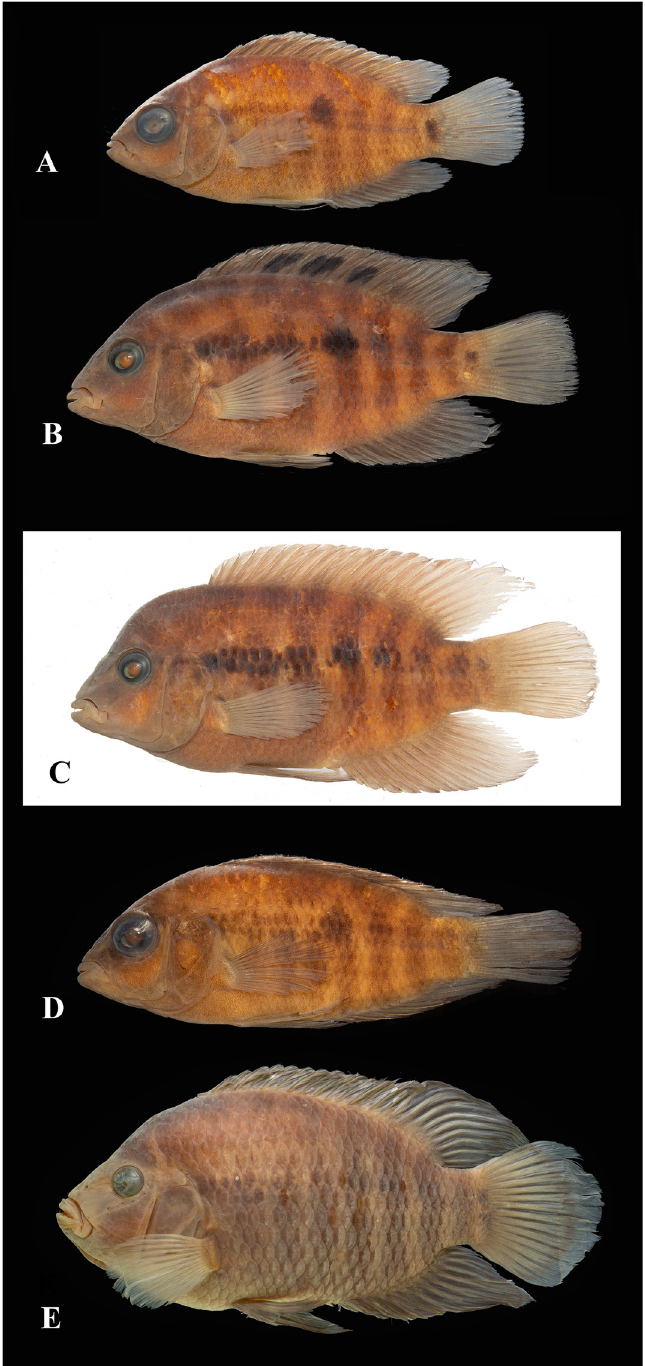
Fig 21. Australoheros acaroides. A. juvenile, 32.5 mm SL; MCP 18317 Brazil: S ã o Francisco de Paula: Rio das Antas on road Jaquirana–Bom Jesus. B . Adult female, 57.7 mm SL; MCP 26548 Brazil: Rio Grande do Sul: Nova Palma: Rio Jacuı´drainage: Arroio Caembora´ close to Caembora´. C . Adult male, 66.1 mm SL; MCP 26548 Brazil: Rio Grande do Sul: Nova Palma: Rio Jacuı´drainage: Arroio Caembora´ close to Caembora´. D . Paratype of Australoheros taura , young, 43.6 mm SL; MCP 42363; Brazil: Rio Grande do Sul: Bom Jesus: Rio Taquari drainage: near Arroio Barreiro, tributary of the Rio das Antas. E . Paratype of Australoheros taura , adult male, 142.0 mm SL; CICMC12102; Brazil: Rio